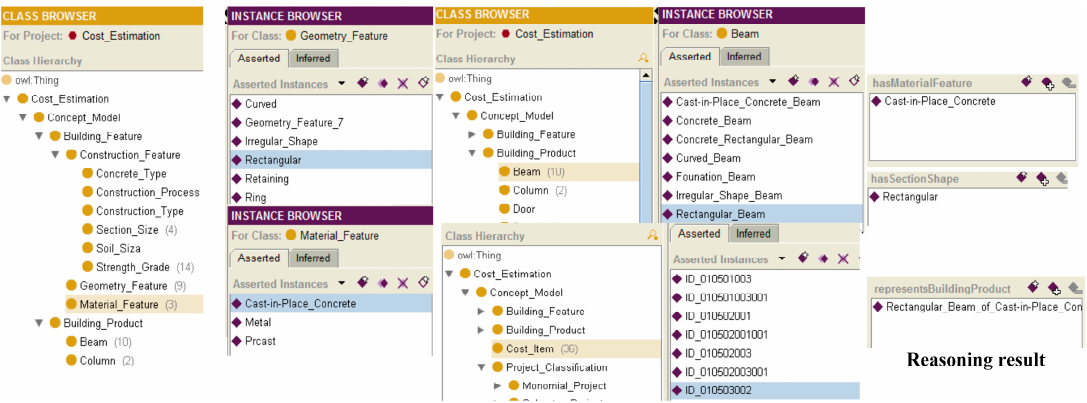
Figure 12. Reasoning result of the concept model ontology.